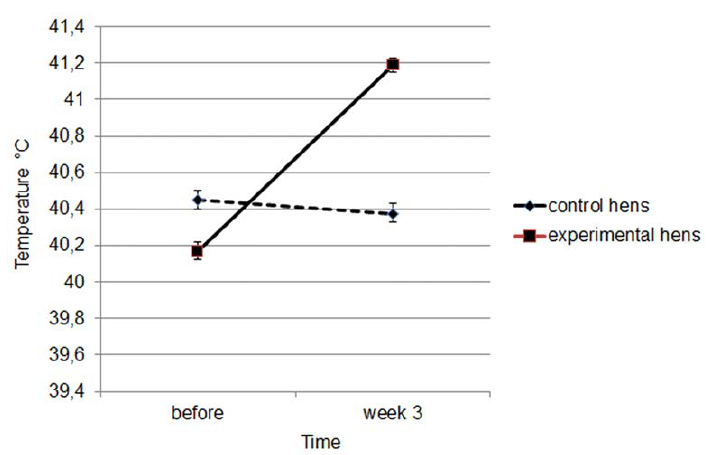
Figure 2. Mean ± SEM internal temperature of control and experimental hens before and during the treatment.